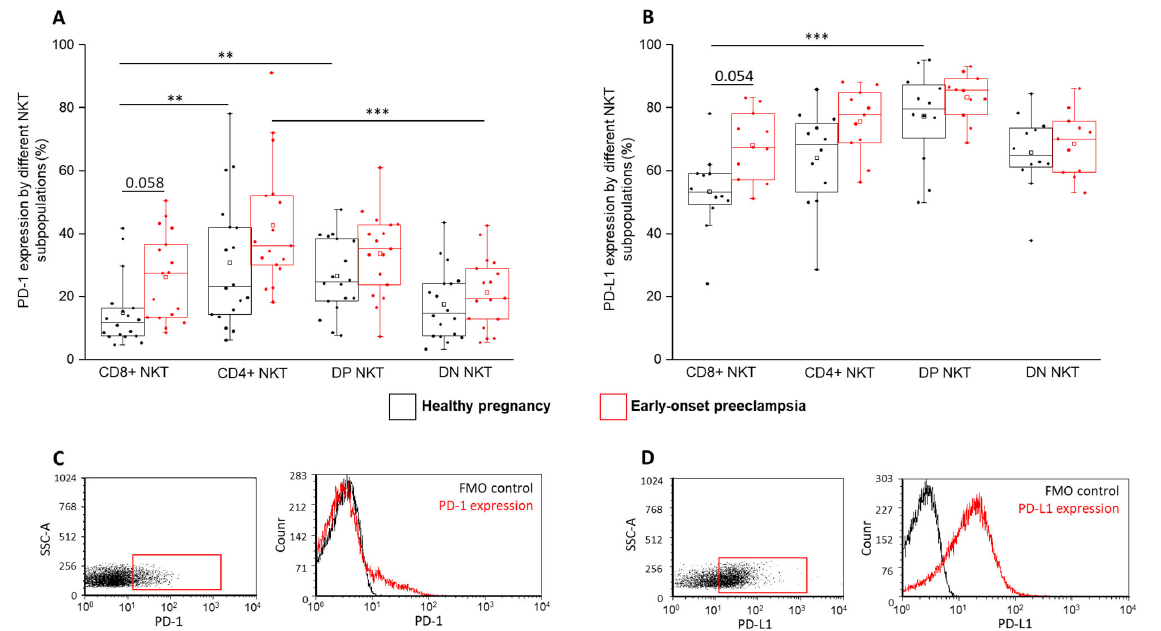
Figure 3. PD ‐ 1 and PD ‐ L1 expression by different NKT cell subpopulations in EOP and healthy pregnancy. PD ‐ 1 receptor expression ( A ) and PD ‐ L1 ligand expression ( B ) by the CD8 and CD4 positive and negative NKT cell subpopulations in EOP patients and healthy pregnant women. The solid bars represent medians of 18 and 17 determinations, respectively. The boxes indicate the interquartile ranges, and the whiskers show the most extreme observations. The middle square within the box represents the mean value. Significant differences with p ‐ values <0.01 *** and <0.03 ** are indicated. Representative FACS plots show the PD ‐ 1 surface marker ( C ) and PD ‐ L1 surface molecule ( D ) expression by cells in the lymphocyte gate. Fluorescent minus one (FMO) control was used to determine PD ‐ 1 and PD ‐ L1 expression.